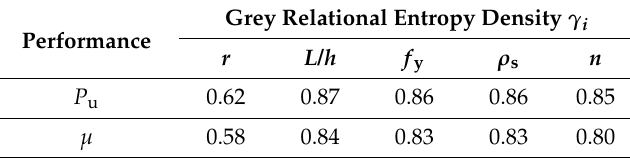
Table 2. Ranking results of grey relational